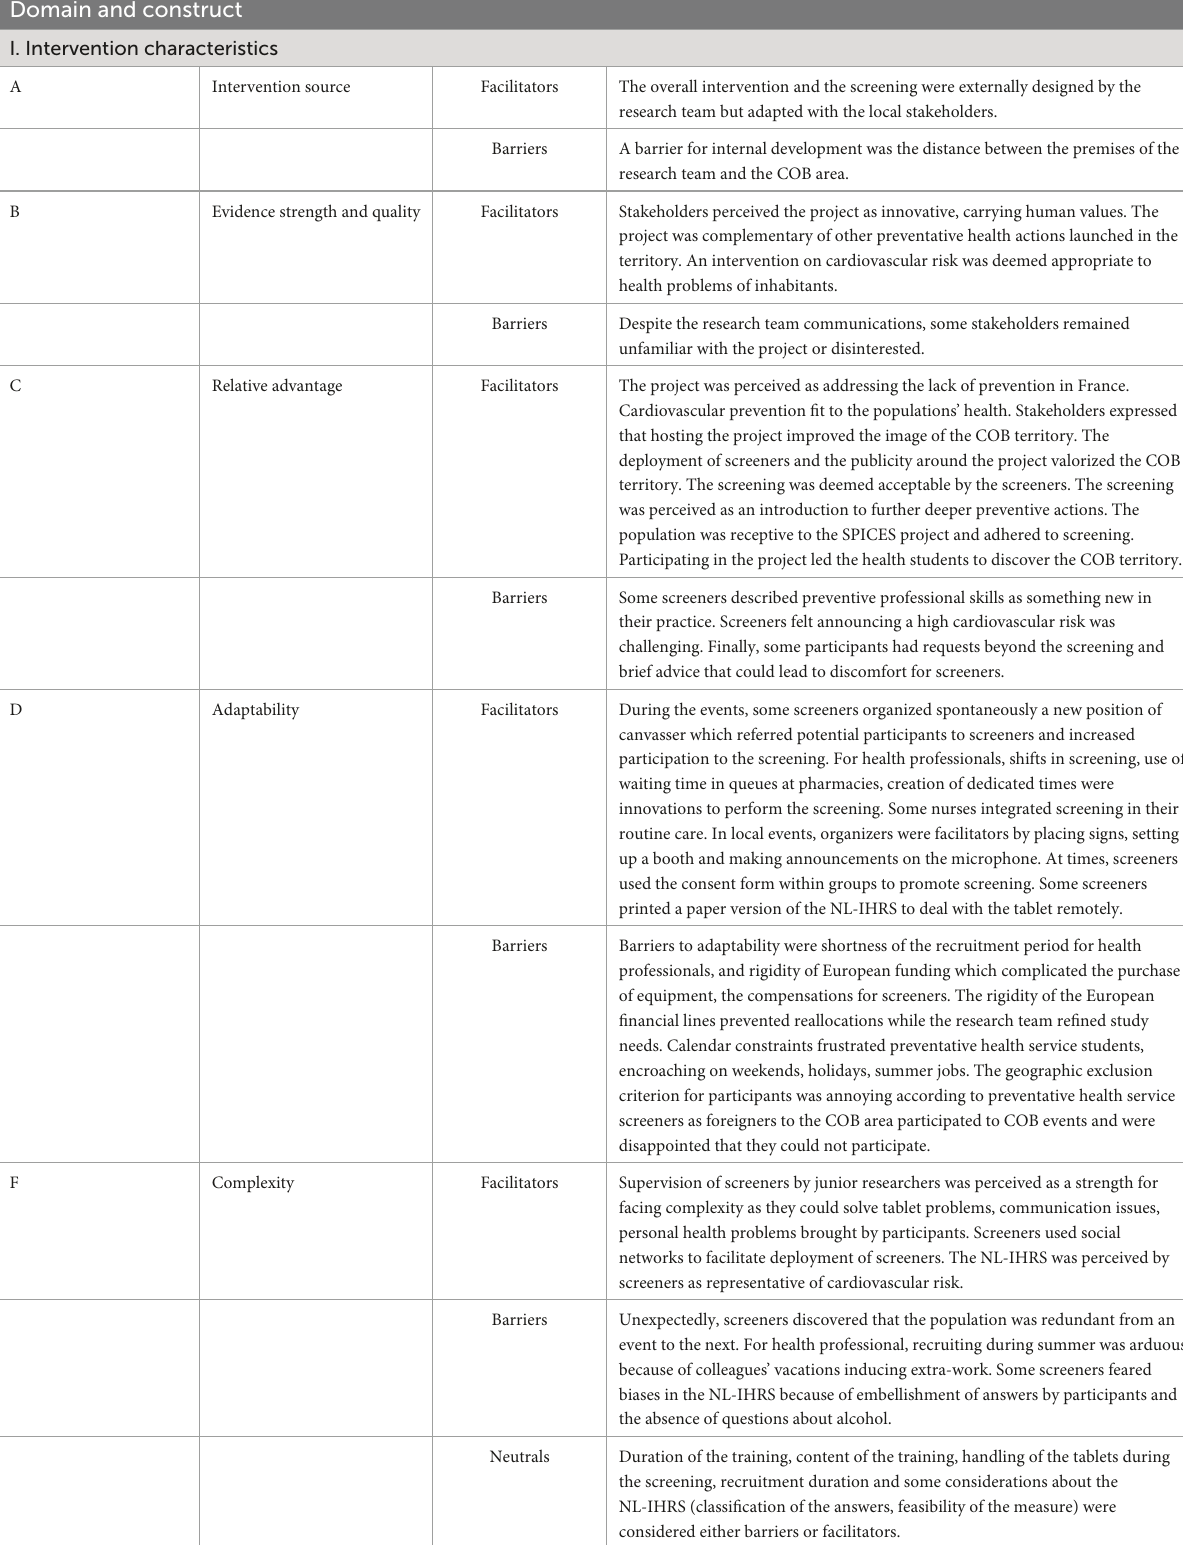
TABLE 3 Facilitators, barriers, and neutral factors summarized following CFIR